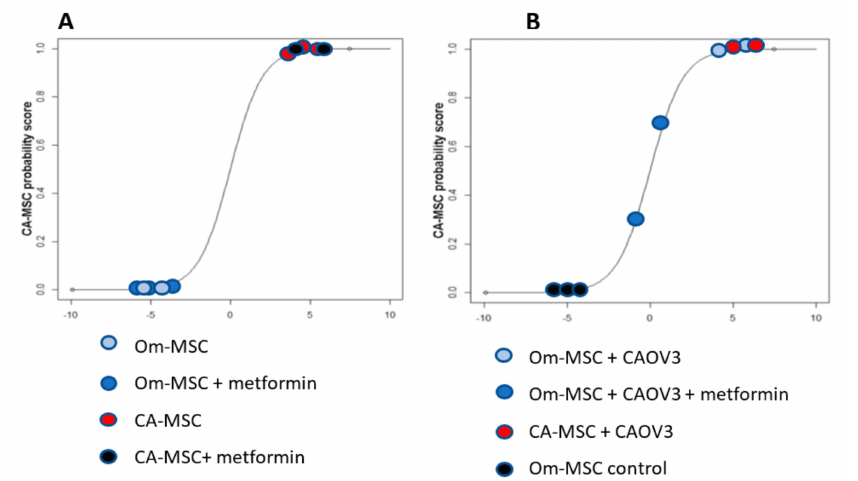
Figure 4. Metformin can prevent the conversion of MSCs to CA-MSCs. ( A ) CA-MSCs derived from chemotherapy-naïve patients did not show a change in the CA-MSC classifier score (0.99–1.00) when treated with metformin in vitro for one week. ( B ) MSC classifier score from MSCs and CA-MSCs isolated from tumor cells:MSC xenografts treated with metformin. MSCs isolated from tumors established with CA-MSCs had a CA-MSC phenotype (0.99). MSCs isolated from tumors established with normal omental MSCs and treated with a vehicle control had a classifier score consistent with reprogramming to CA-MSCs (classifier scores of 0.98–0.99). Human MSCs isolated from